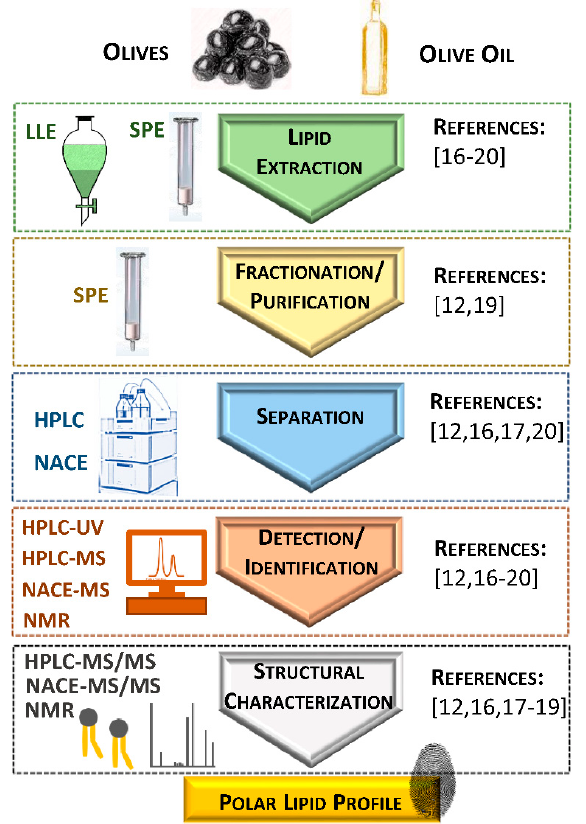
Figure 1. Schematic representation of the methodological approaches used for studying polar lipids from olives and olive oil. Abbreviations: HPLC, high-performance liquid chromatography; HPLC-MS, high-performance liquid chromatography coupled to mass spectrometry; HPLC-MS/MS, high-performance liquid chromatography coupled to tandem mass spectrometry; HPLC-UV, high-performance liquid chromatography with ultraviolet detector; LLE, liquid/liquid extraction; NACE, non-aqueous capillary electrophoresis; NACE-MS, non-aqueous capillary electrophoresis coupled to mass spectrometry; NACE-MS/MS, non-aqueous capillary electrophoresis coupled to tandem mass spectrometry; NMR, nuclear magnetic resonance; SPE, solid-phase extraction.